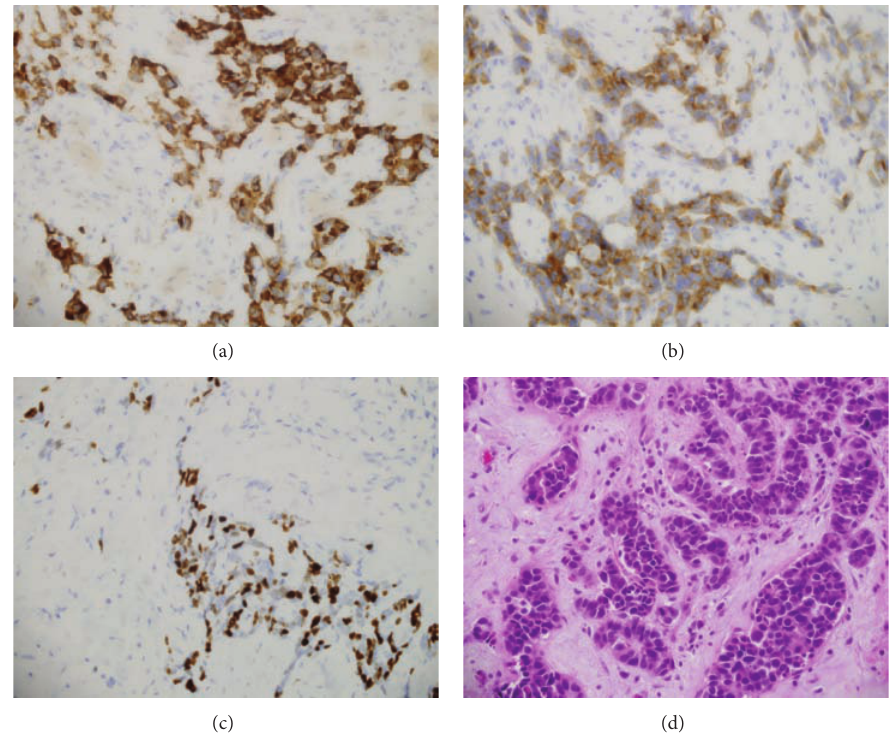
Figure 3: Histopathology of surgical specimen showing (a) chromogranin positivity, (b) synaptophysin positivity, (c) Ki-67 positivity, and (d) hematoxylin and eosin stained small cells consistent with small cell carcinoma of gallbladder.